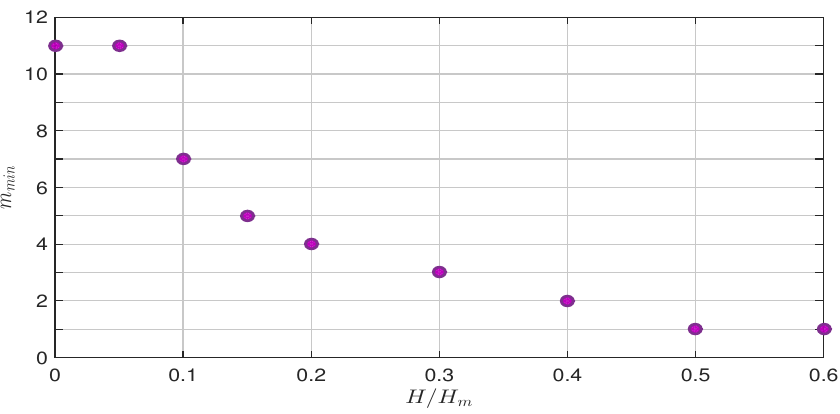
˜ t such that t = 0 corresponds −